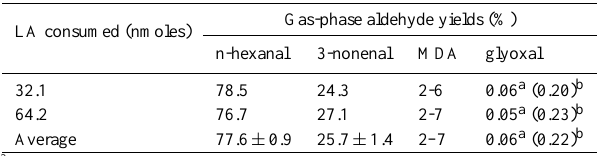
Table 2. Gas-phase aldehyde formation yields relative to the amount of LA consumed from Type 2 experiments with